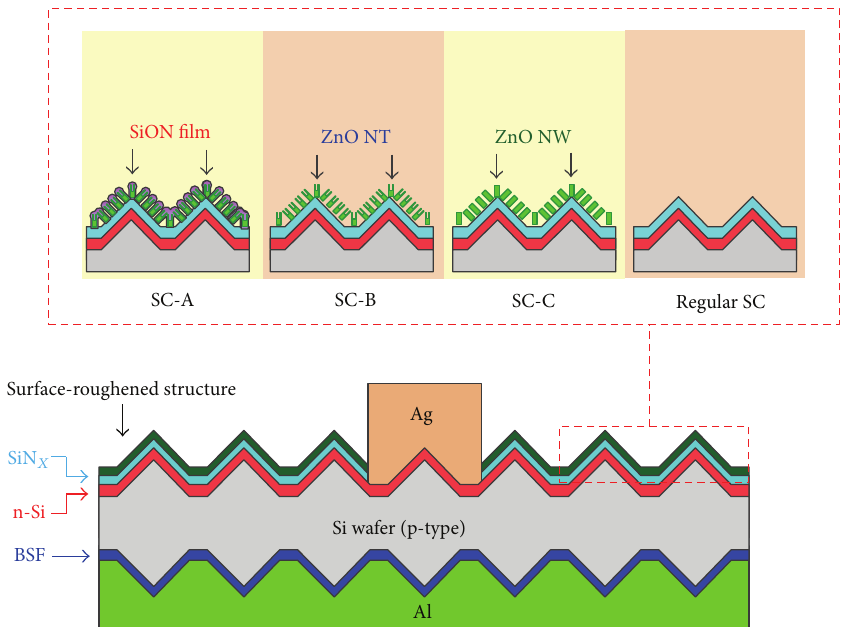
Figure 1: Schematic device structures of SC-A (with SiON/ZnO NT arrays), SC-B (with ZnO NT arrays), SC-C (with ZnO NW arrays), and regular SC (with KOH-etched surface).